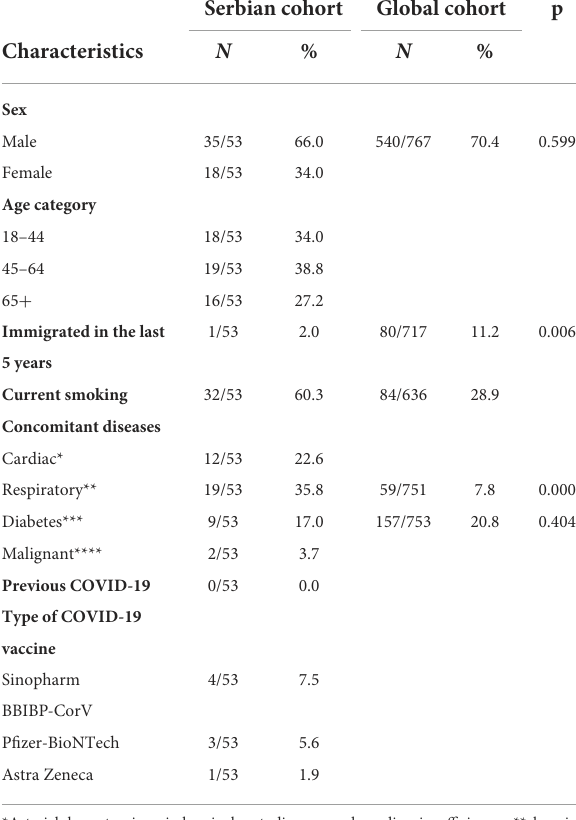
TABLE 1 Characteristics of TB/COVID-19 cases in Serbia ( n = 53) compared to the global cohort. Serbian cohort Global cohort